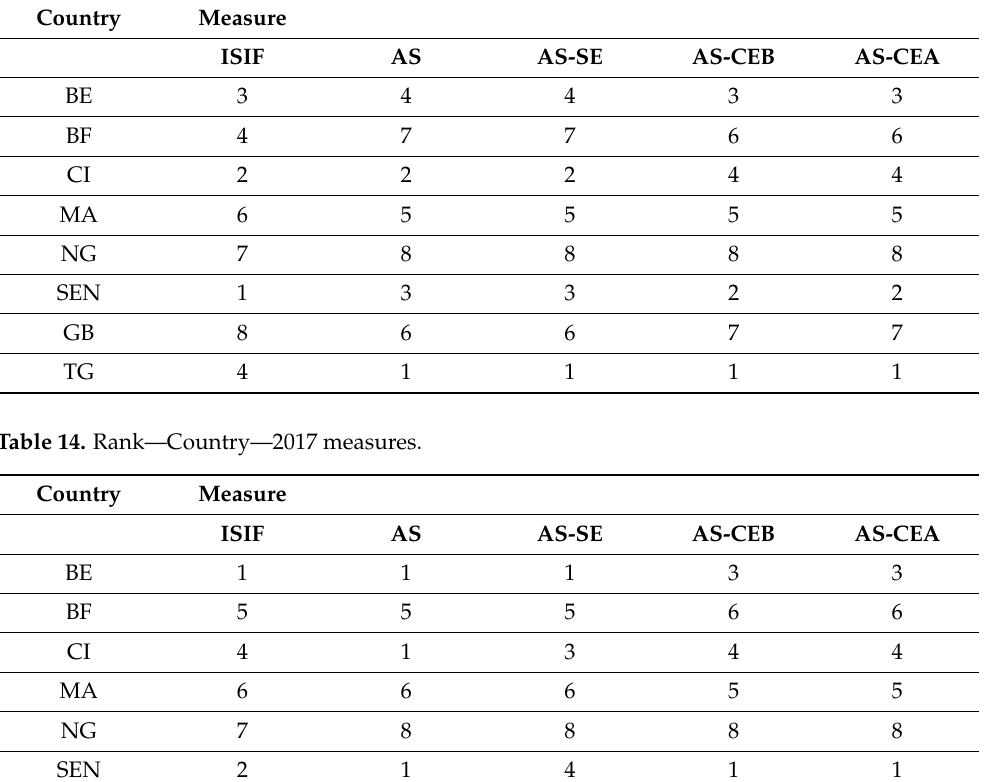
Table 13. Rank—Country—Average measures. Country Measure ISIF AS AS-SE